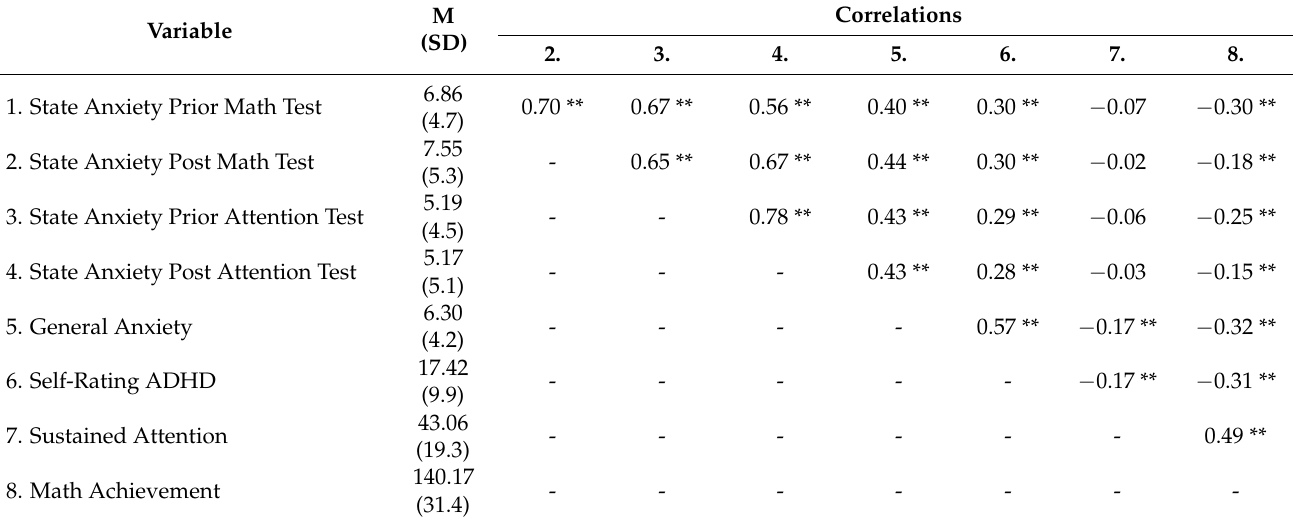
Table 1. Descriptive statistics and bivariate